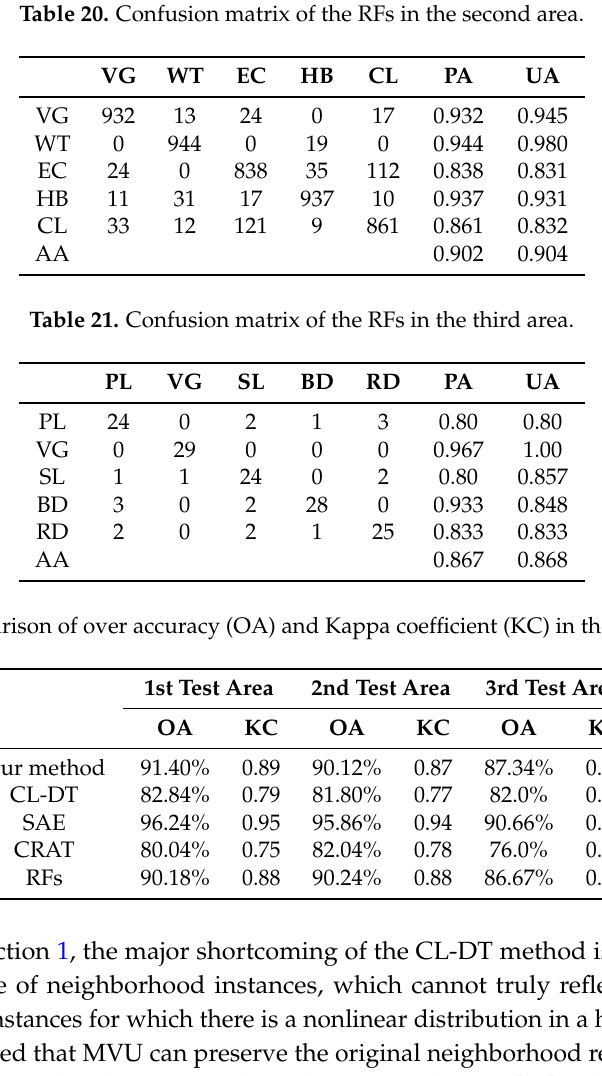
Table 20. Confusion matrix of the RFs in the second area.